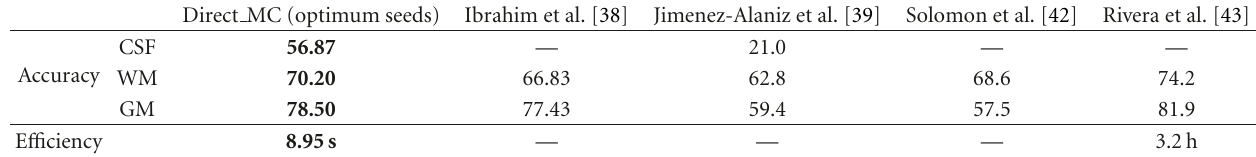
Table 3: Segmentation accuracy (Tanimoto coe ffi cient) and e ffi ciency (average execution time per volume) for IBSR